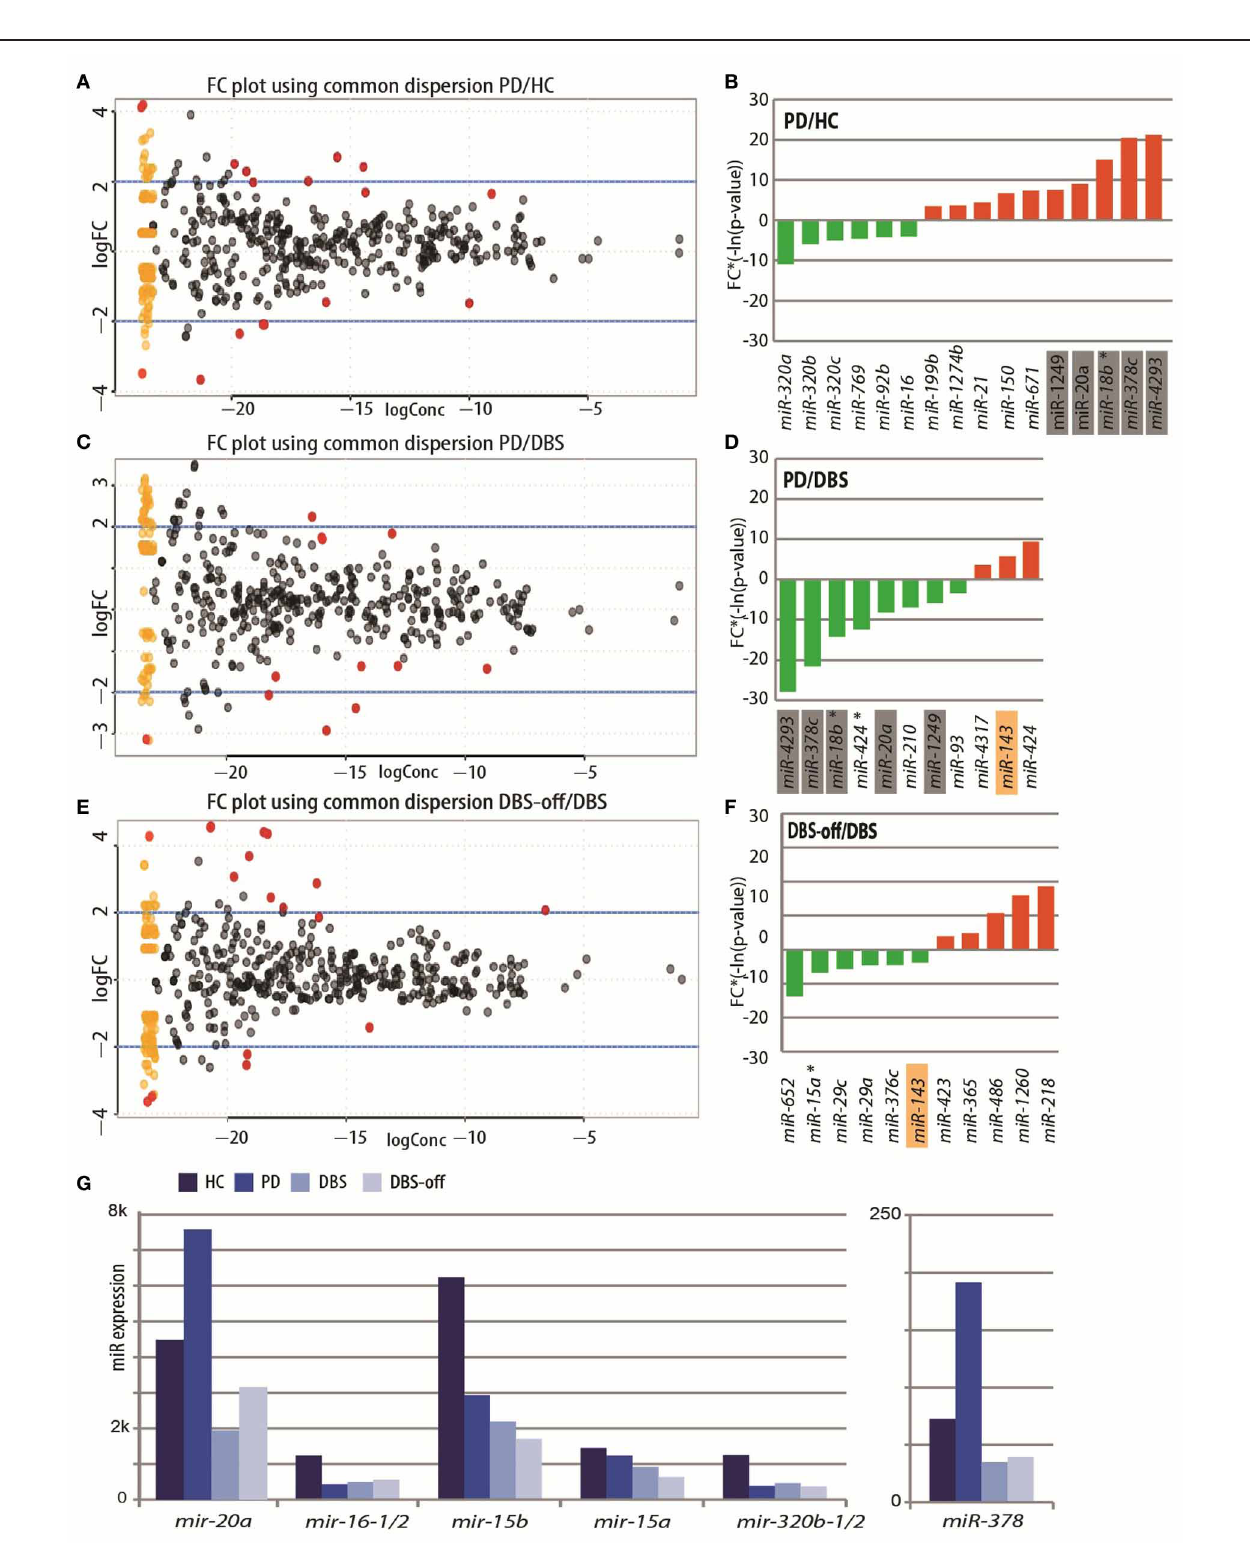
FIGURE 2 | Changed miRNA profiles in PD patients pre-and post-DBS and under stimulation cessation. (A,C,E) . Log concentrations ( X -axis) and log 2 fold change (FC) ( Y -axis) of miRNAs detected as differentially expressed in (A) PD patient leukocytes pre- DBS as compared with healthy volunteers,